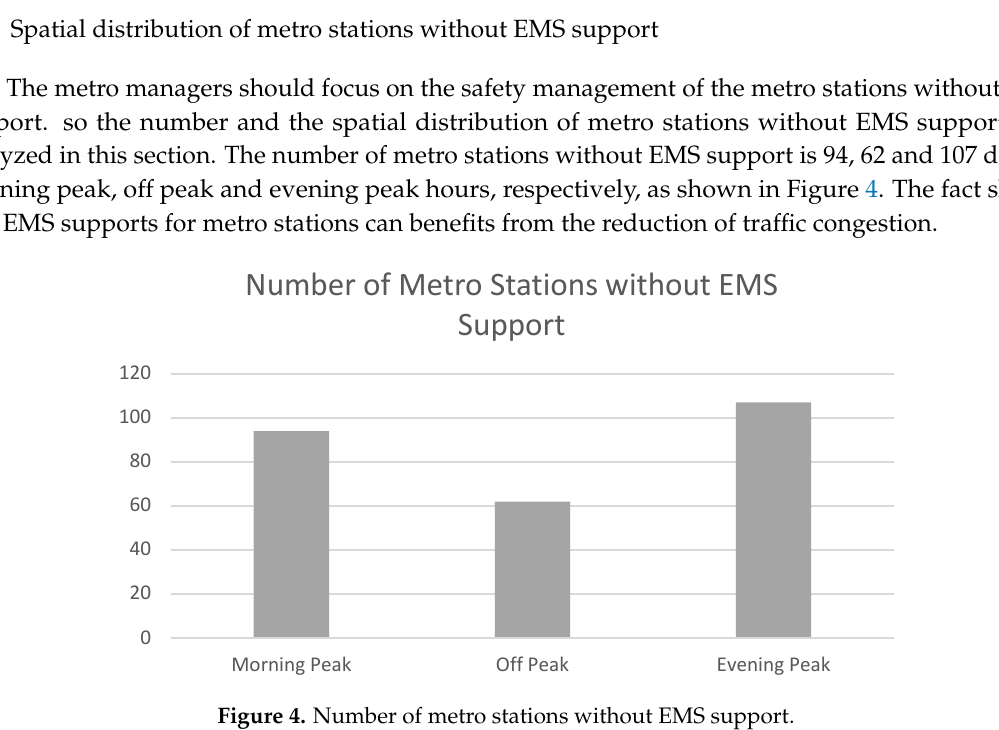
Figure 4. Number of metro stations without EMS support.